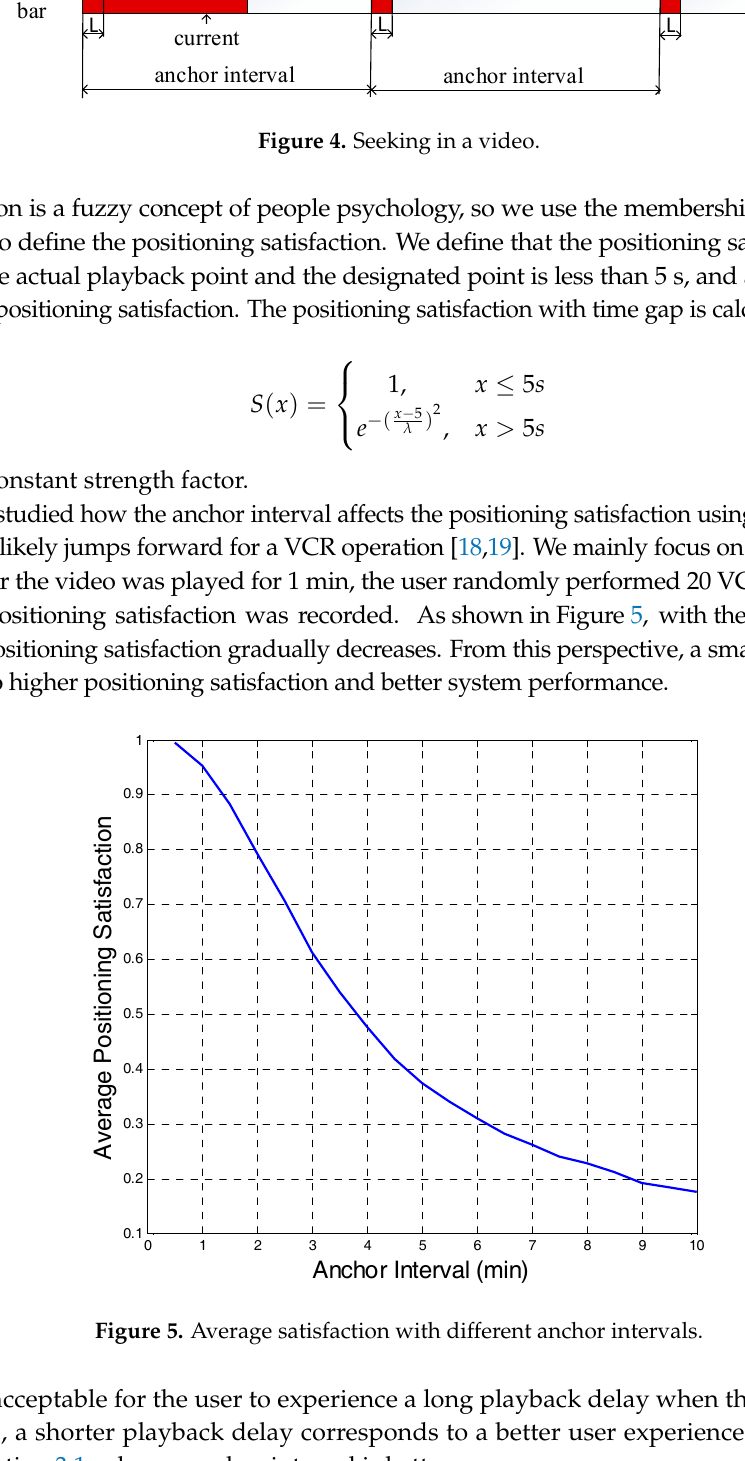
Figure 5. Average satisfaction with different anchor intervals.